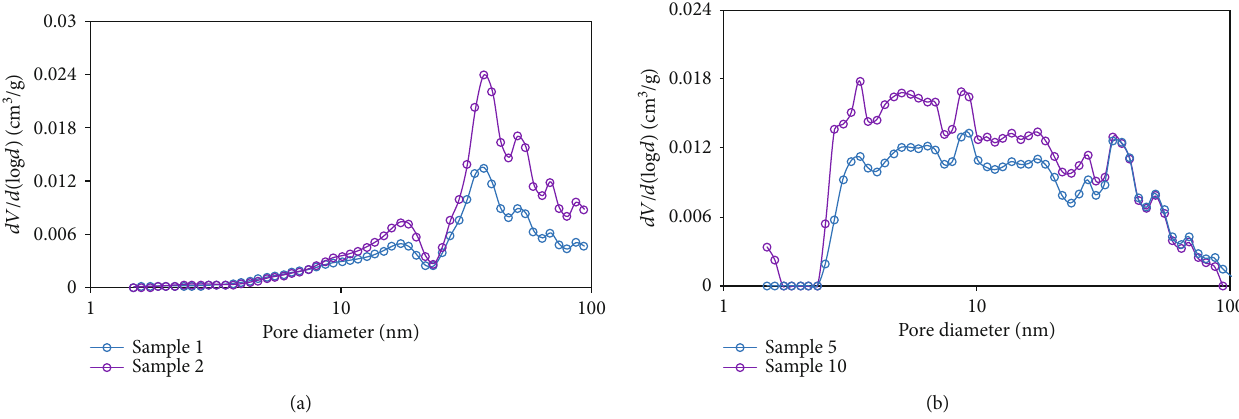
qn Formation. (a) The pore size distributions of type A. (b) The pore size 2 1